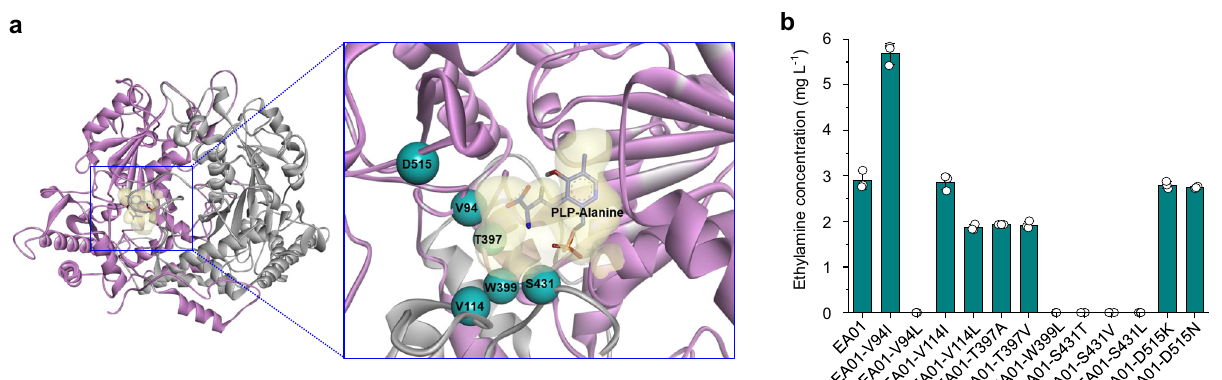
Fig. 8 Protein engineering of VlmD for the enhanced production of ethylamine. a Binding model of PLP- L -alanine in the homology model of VlmD. The homology model was generated using glutamate decarboxylase from Homo sapiens as a template. Potential six target residues for enzyme engineering are shown in cyan. b The concentrations of ethylamine produced by fl ask cultures of the EA01 strain and its derivative strains having one of the 12 different VlmD variants (Supplementary Table 2). Experiments were conducted in triplicates. Data are presented as mean values ± s.d. Source data are provided as